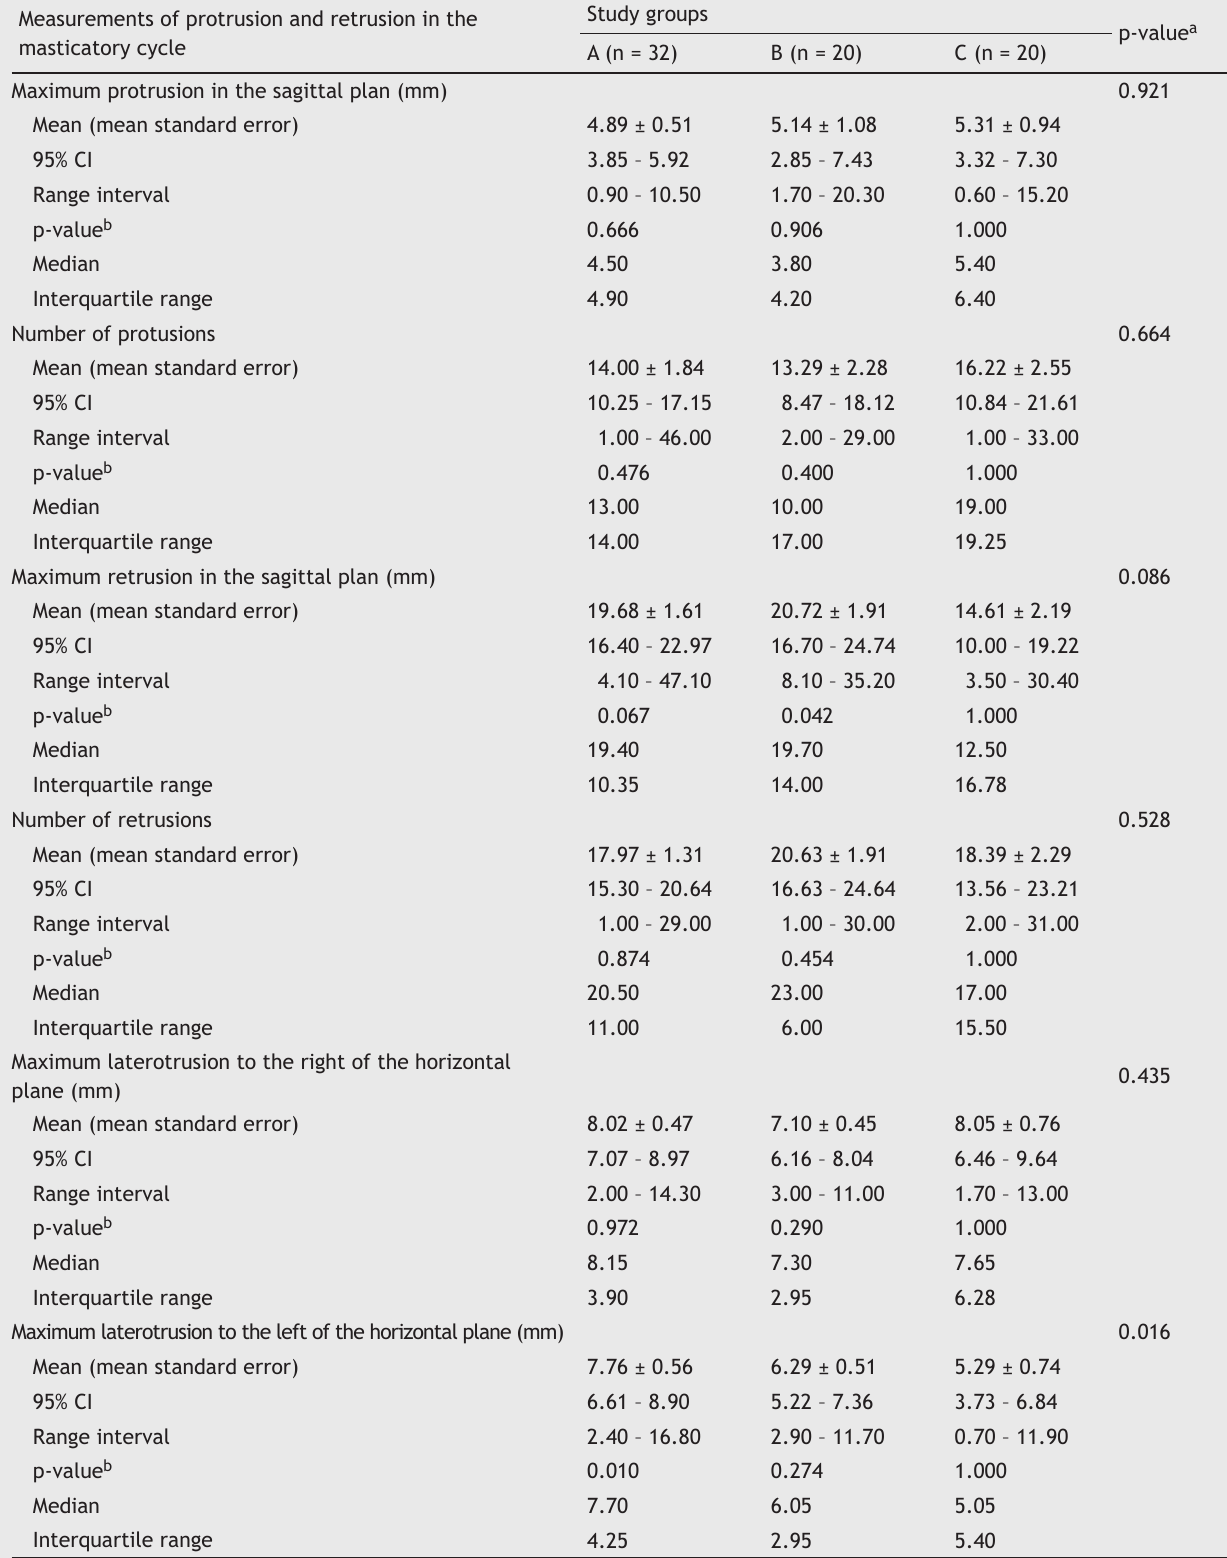
Table 2 Statistical parameters of protrusion and retrusion in the masticatory cycle. Measurements of protrusion and retrusion in